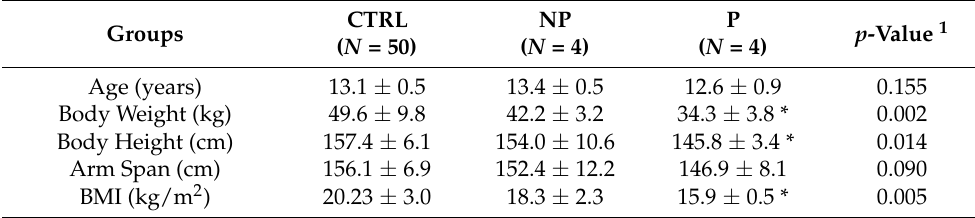
Table 1. Basic information for the three